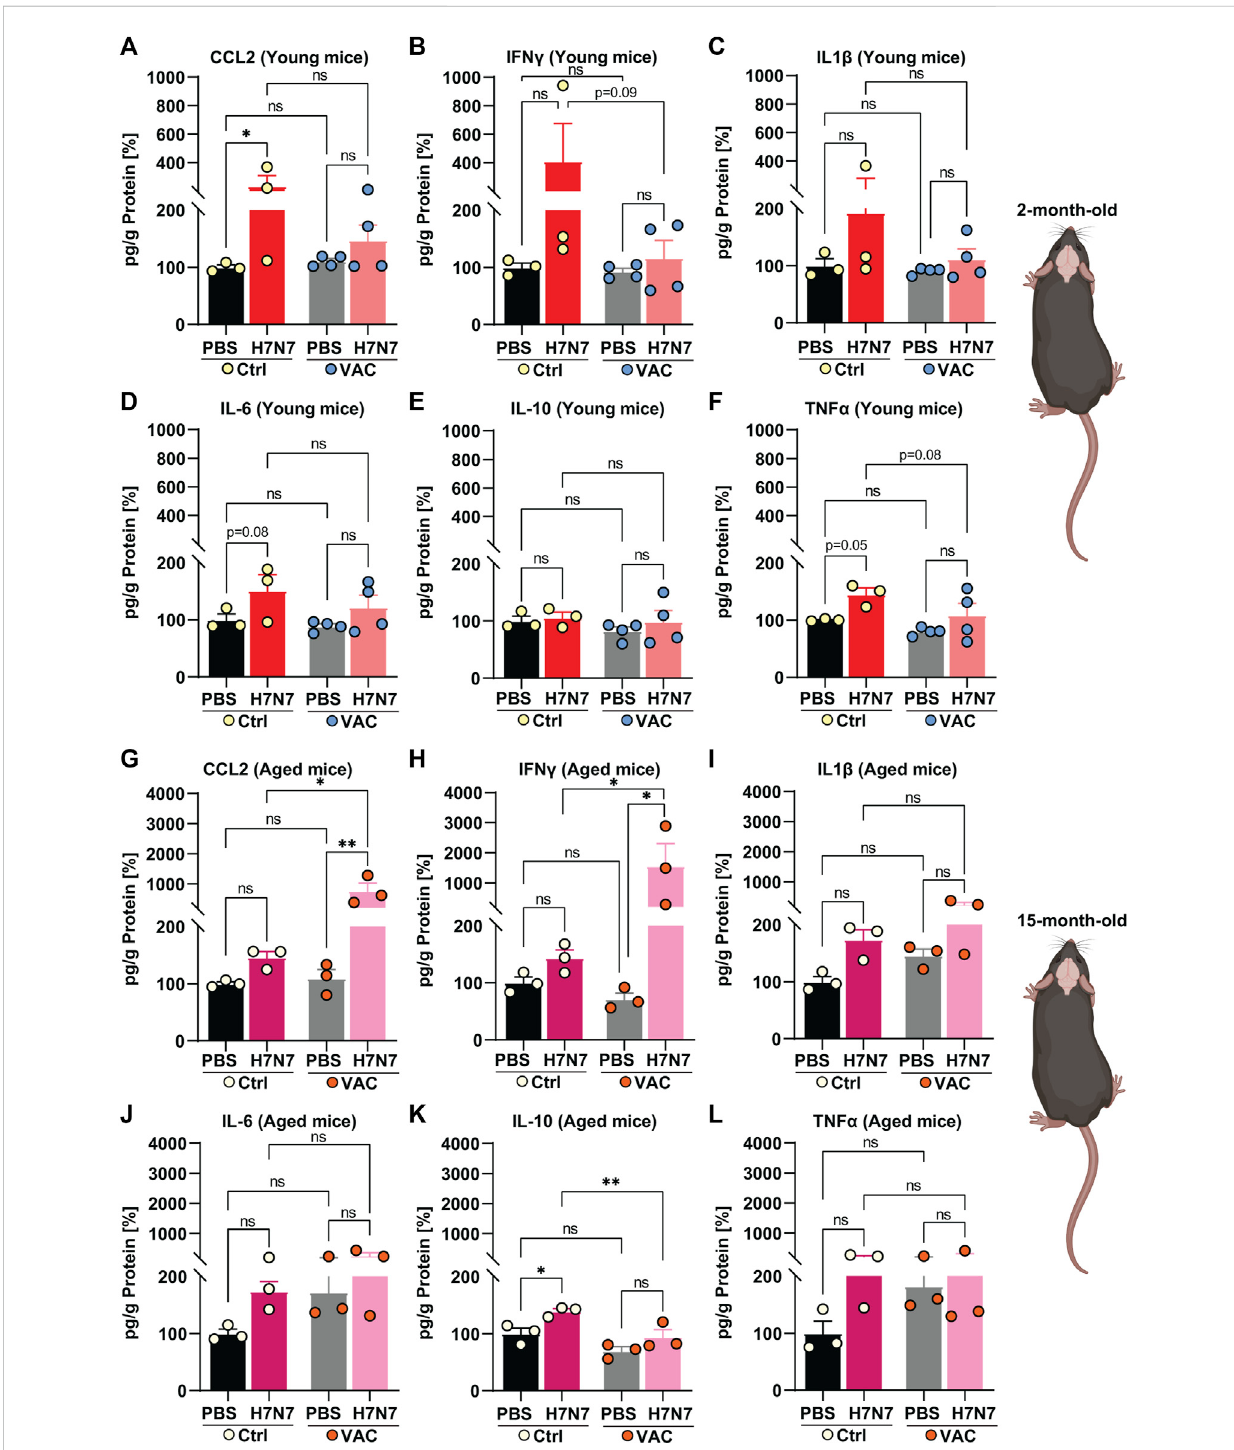
FIGURE 3 Effects of vaccination on the release of cytokines and chemokines in the brain induced by H7N7 IAV infection. In the brains of young mice, levels of (A) CCL2, (B) IFN γ , (C) IL1 β , (D) IL-6, and (F) TNF α increased after H7N7 IAV infection, whereas vaccination prevented this increase and resulted in a lower release of these mediators in the brain of infected mice. (E) IL-10 was not increased in the brains of H7N7 IAV infected mice, regardless of whether they were vaccinated or not ( n = 3 – 4 animals per group). In the brains of older mice, H7N7 IAV infection resulted in increased release of (G) CCL2, (H) IFN γ , and (I) IL1 β independent of vaccination. CCL2 and IFN γ levels were even higher in the brains of infected mice that had been previously vaccinated. Levels of (J) IL-6 and (L) TNF α were higher in the brains of unvaccinated mice after H7N7 IAV infection than in the Ctrl-PBS group. (K) IL-10 levels increased only in the brains of unvaccinated mice after H7N7 IAV infection ( n = 3 animals per group). Data are presented as mean ± SEM and were analyzed with an ordinary two-way ANOVA followed by Fisher ’ s LSD test; * p < 0.05, and ** p <